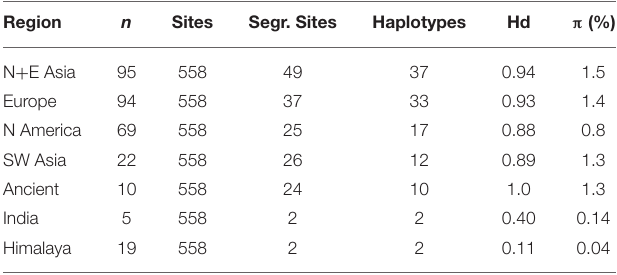
TABLE 1 | Genetic diversity according to geographical region based on alignment A excluding indels (558 bp); Hd = haplotype diversity, π = nucleotide